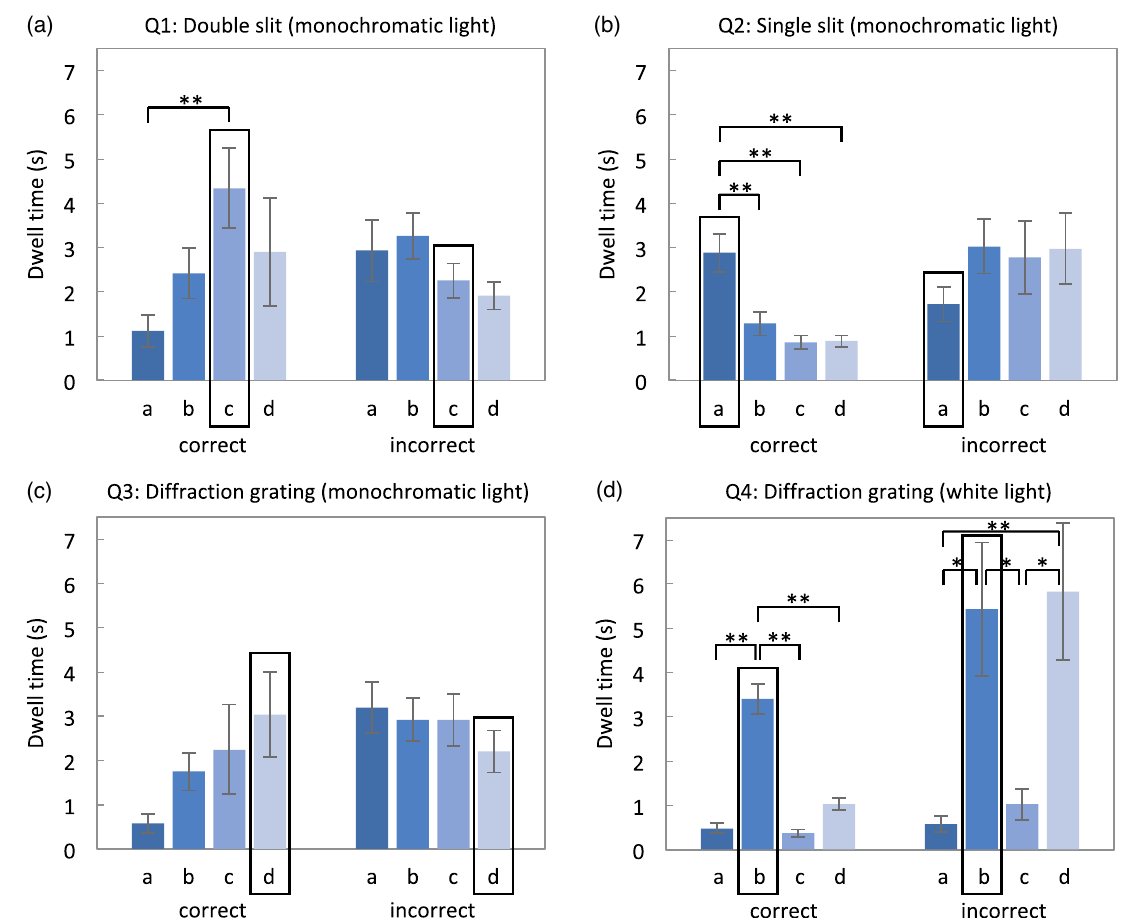
FIG. 2. Dwell times for multiple-choice answers ( a , b , c , and d ) for each question (Q1, Q2, Q3, and Q4), evaluated separately for students who correctly and incorrectly answered the question. Rectangles show correct answers. One or two asterisks indicate significantly different pairwise comparisons at levels of p < 0 . 05 or p < 0 . 01 ,